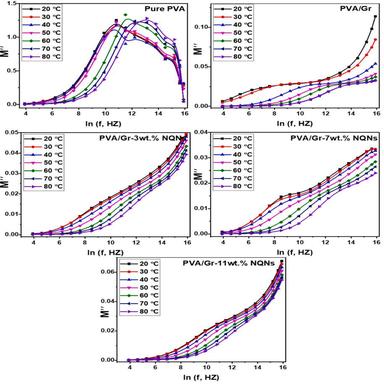
The M″ as a function of ln (f) for the pure PVA and the fabricated PNCs (PVA/Gr, PVA/Gr-3 wt% NQNs, PVA/Gr-7 wt% NQNs, and PVA/Gr-11 wt% NQNs). The measurements were conducted at temperatures (20–80 ◦C) and at different applied frequencies starting from 50 Hz up to 8 MHz.